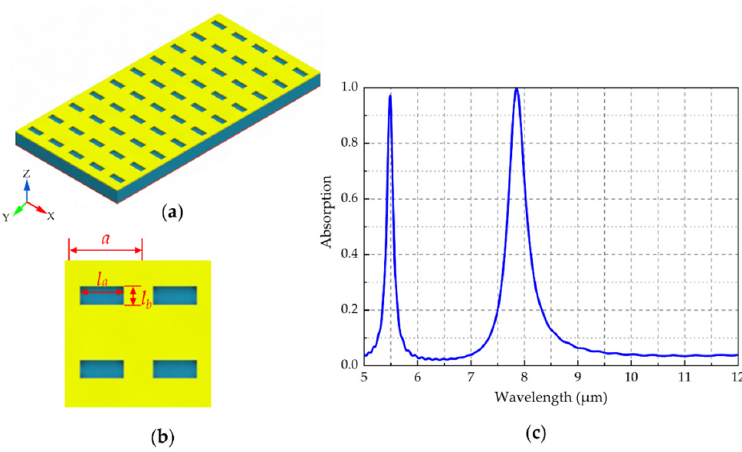
Figure 5. ( a ) Overview, ( b ) top view, and ( c ) simulated absorption spectrum of the metal-insulator-metal ( MIM) structure with the rectangle aperture array.